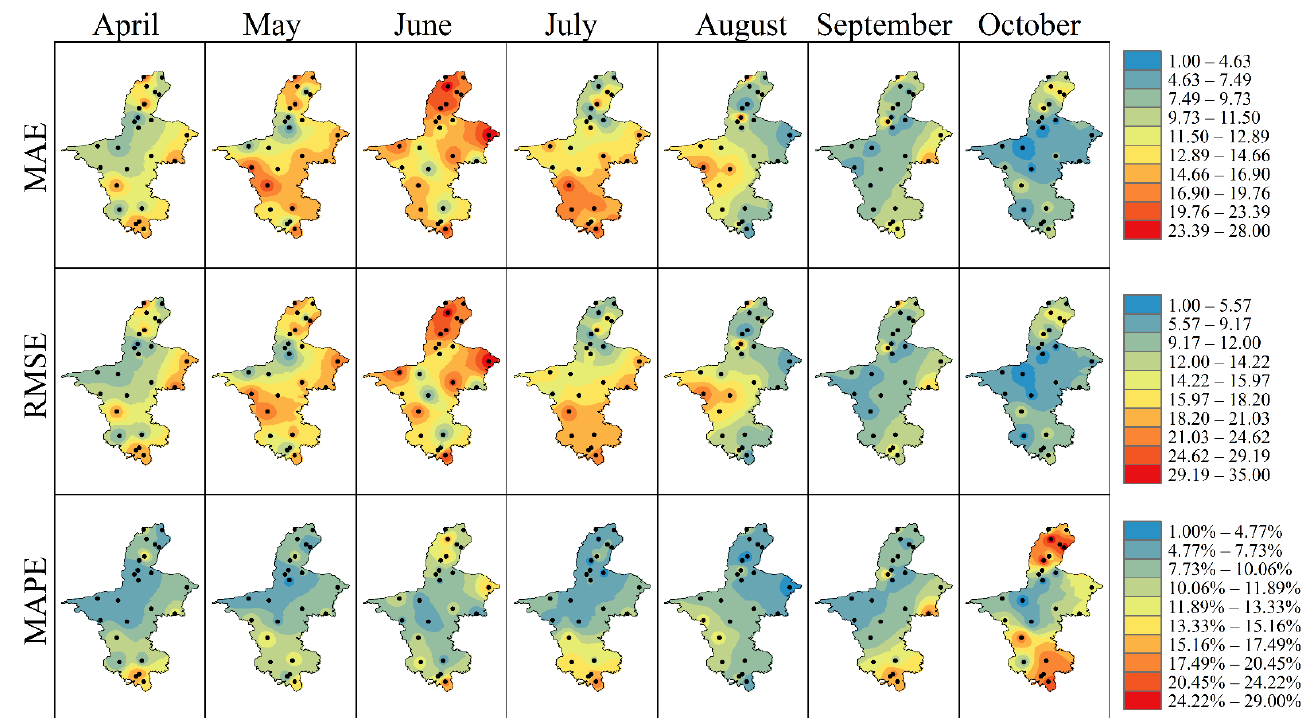
Figure 11. Monthly extrapolated predicted values of potential evaporation in various regions of Ningxia .